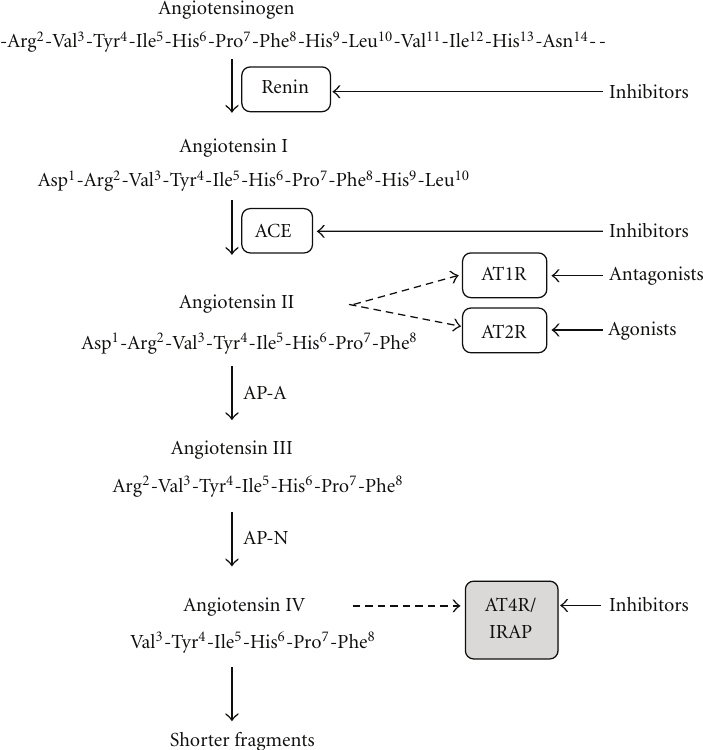
Figure 1: A part of the renin-angiotensin system (RAS), including selected degradation products and drug